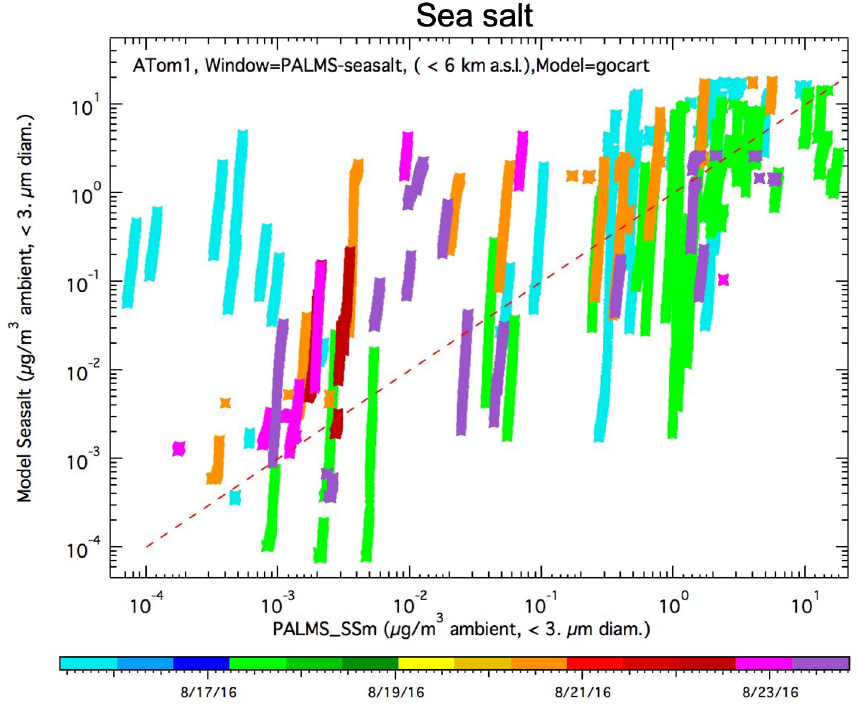
Figure 16. GOCART model forecast versus ATom-1 observed sea salt below